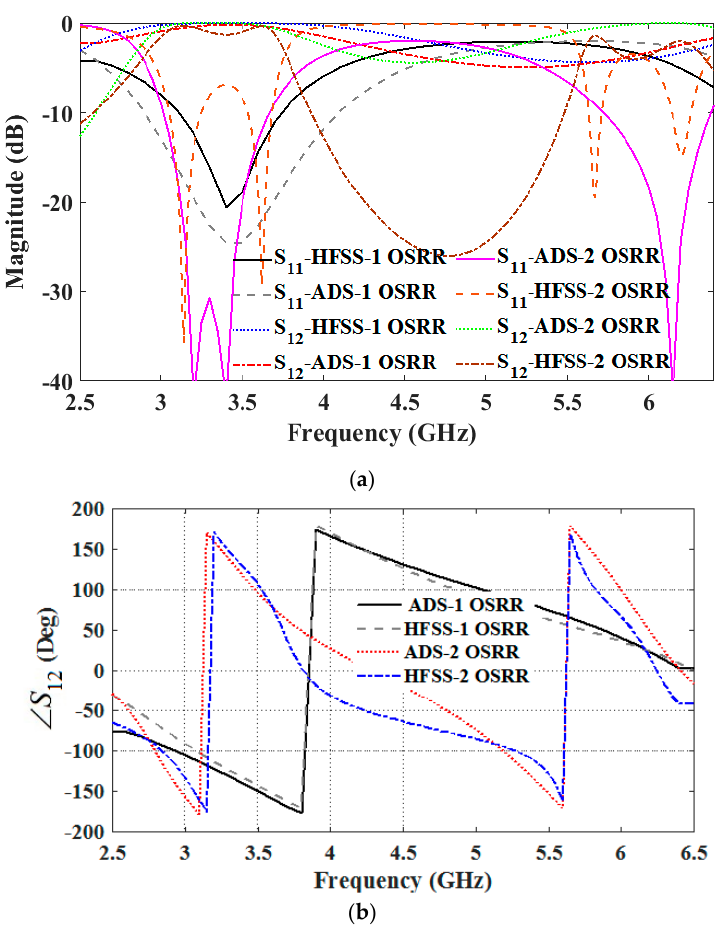
Figure 4. The amplitude and phase response of the proposed transmission lines circuit and EM simulations: ( a ) the magnitude of reflection and transmission coefficients and ( b ) the phase response of S 12